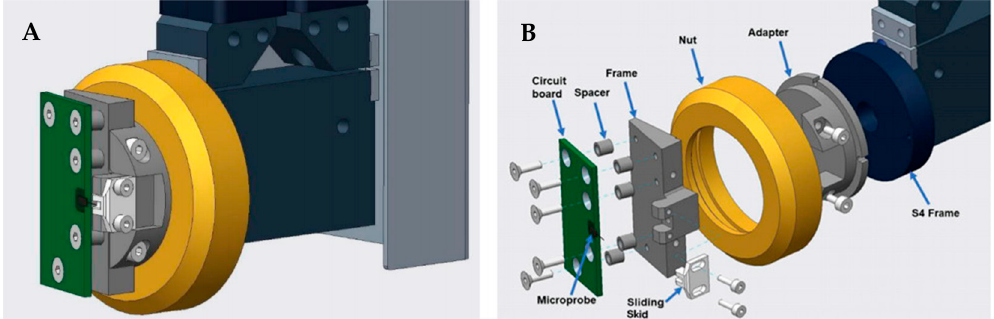
Figure 8. CAD design ( A ) and exploded view ( B ) of microprobe integration in a roll measuring instrument.